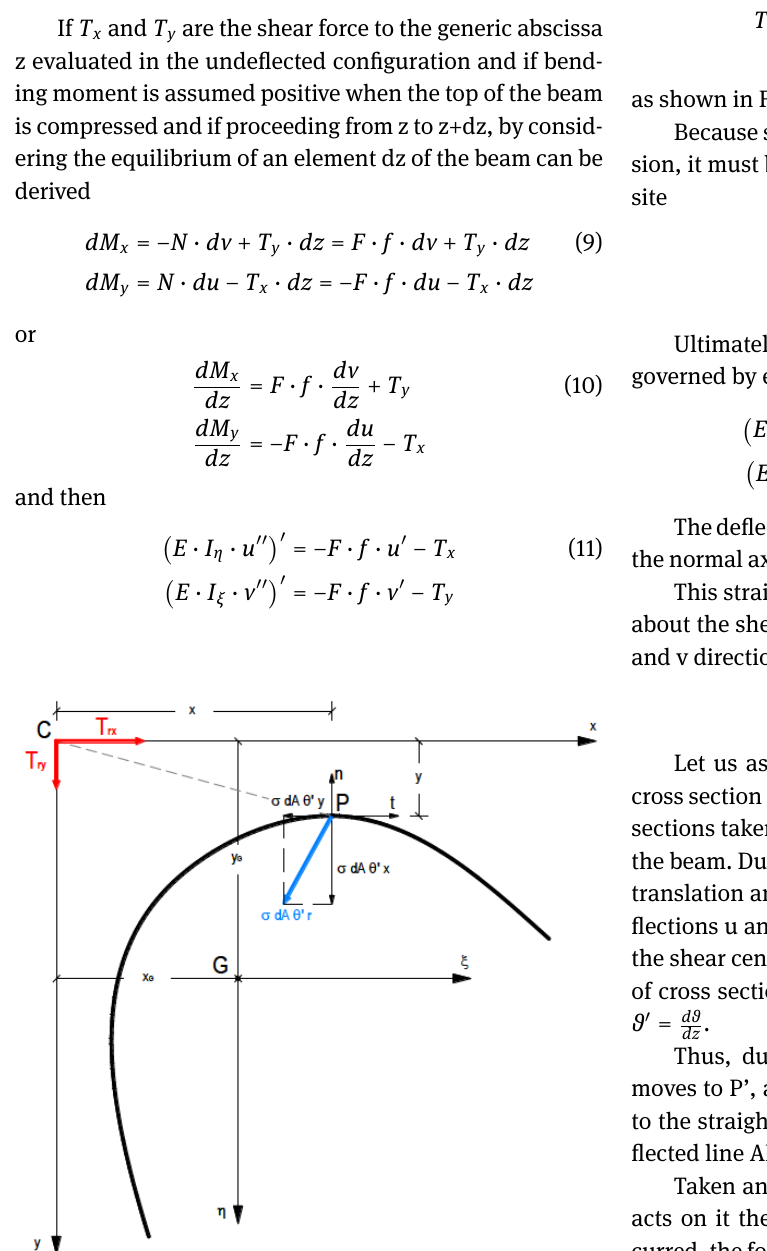
Figure 2: Cross section of the beam.